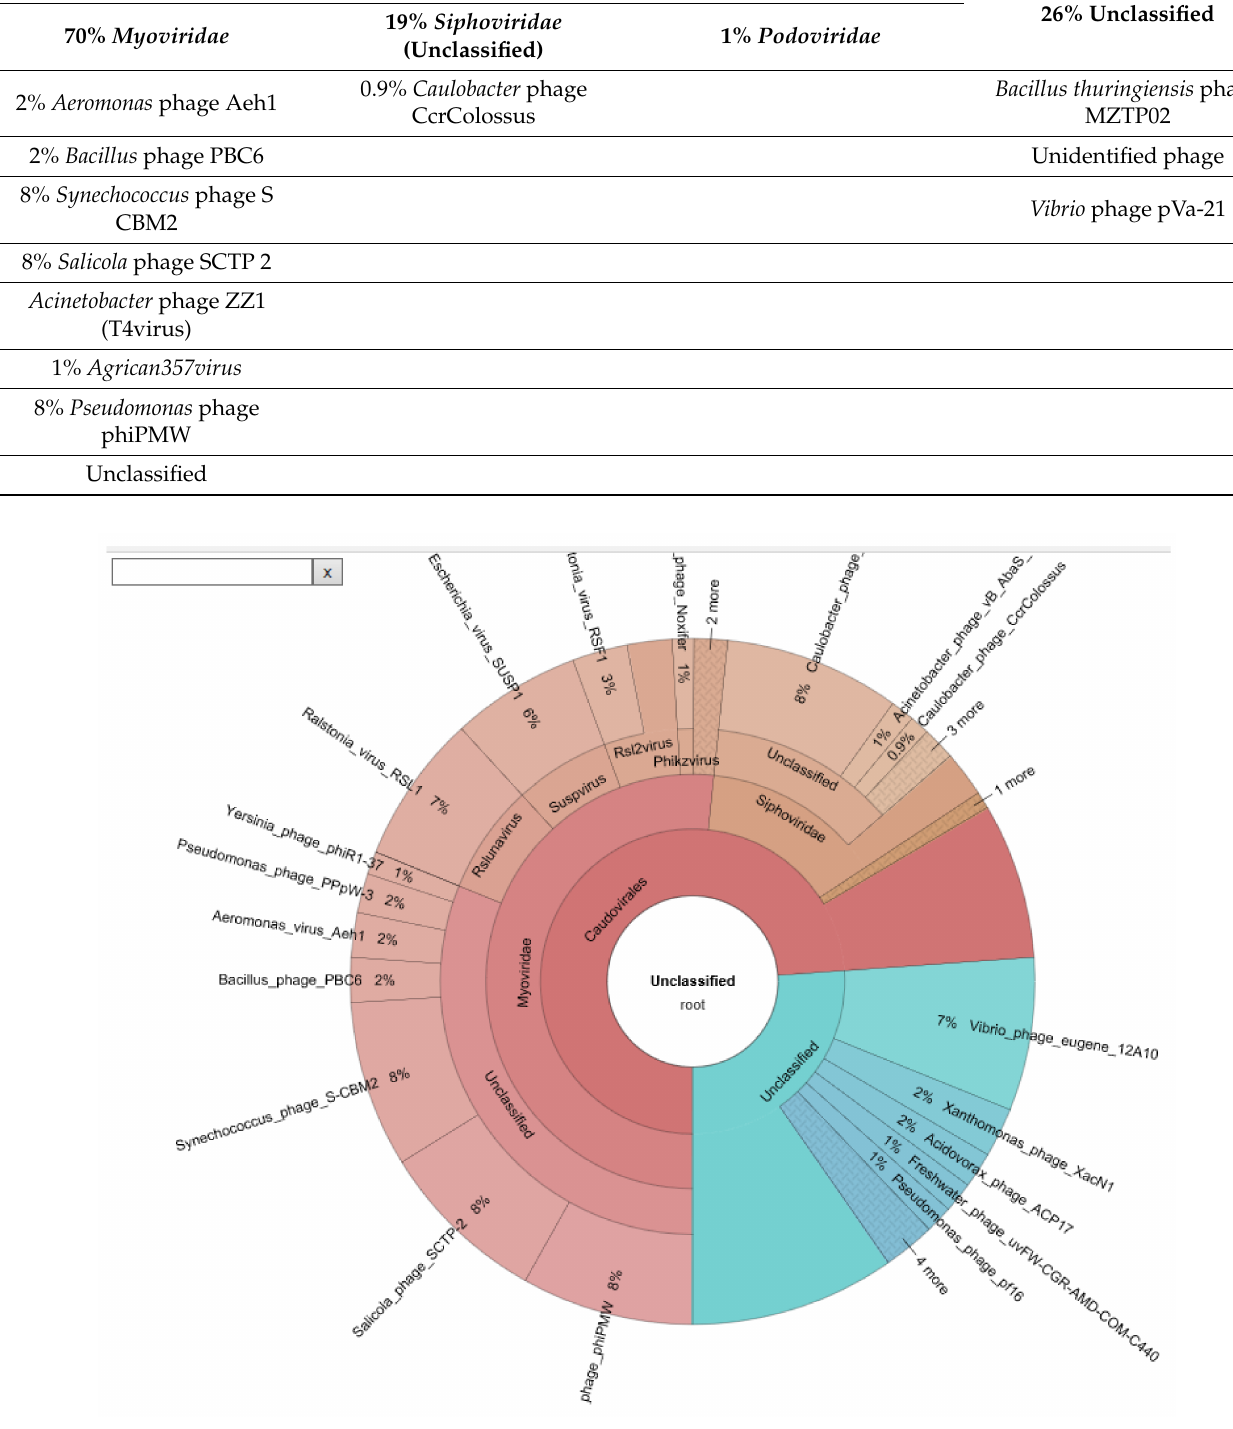
Figure 14. The percentage of bacteriophages identified by shotgun metagenomic